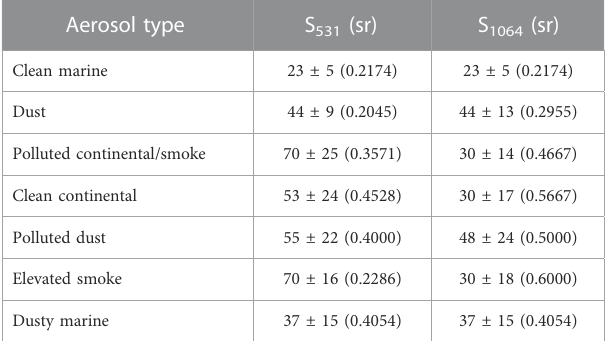
TABLE 1 Lidar ratios and absolute (relative) uncertainties for tropospheric aerosol types for CALIOP V4 aerosol retrievals (Kim et al., 2018). Aerosol